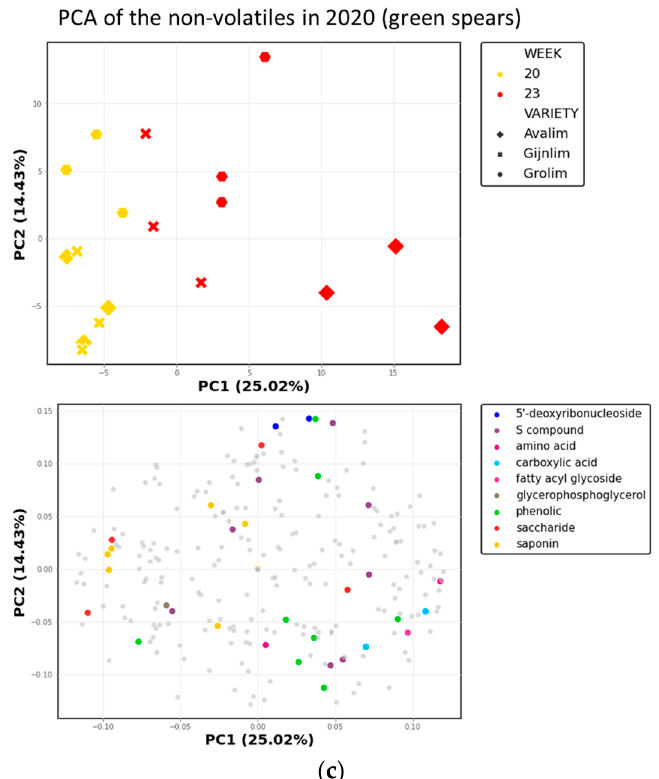
Figure A2. PCA of the non ‐ volatile profiles of the white and green asparagus spears; the first three PCs are given and the explained variance is shown in parentheses on the axes. In the score plots, colour indicates the calendar week of harvest in 2020, symbol shapes indicate asparagus variety. In the loading plot, colour indicates the compound class of the tentatively identified volatiles. Unidentified volatiles are coloured grey: ( a ) score and loadings plot of the first two PCs from PCA of the non ‐ volatiles of white spears; ( b ) score and loadings plot of the first and third PCs from PCA of the non ‐ volatiles of white spears; ( c ) score and loadings plot of the first two PCs from PCA of the non ‐ volatiles of green spears.